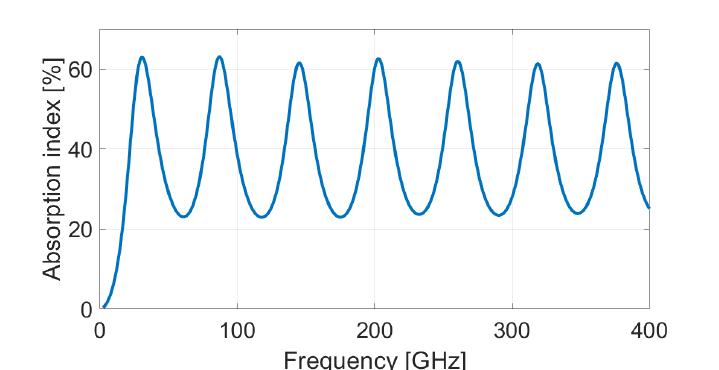
Figure 4. Simulation of absorption index of a PLA-based Salisbury screen. The resistive sheet is a 200 µm-thick rPLA–4%OMMT films and the lossy material is a 1200 µm-thick rPLA